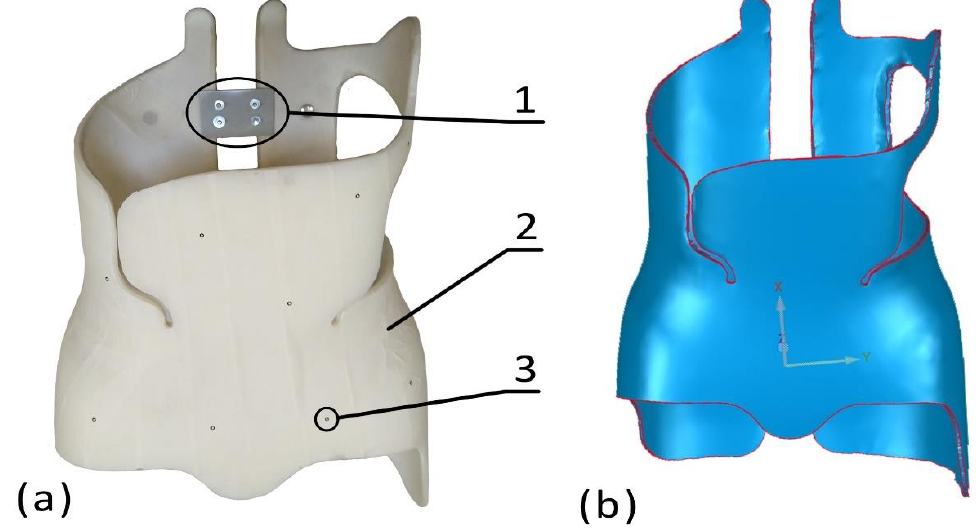
Figure 4. Reverse engineering as the process of creating a 3D model of an orthopaedic brace from the actual facility: ( a ) orthosis ready for scanning: 1—fixing brace stiffener, 2—matted outer layer of the orthoses, 3—reference markers, ( b ) CAD computer model of the orthosis.